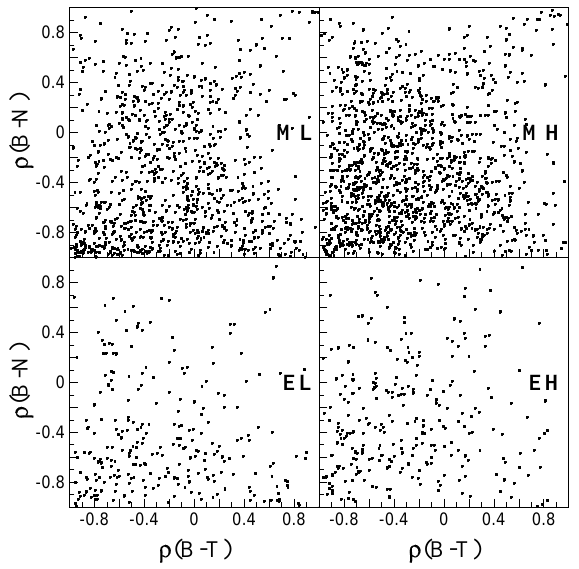
Fig. 7. Scatter plots of ρ ( N − P t ) vs. ρ(P m - P k ) for mid- and low- latitude samples M and E, separately for low (L) and high (H) speed wind.